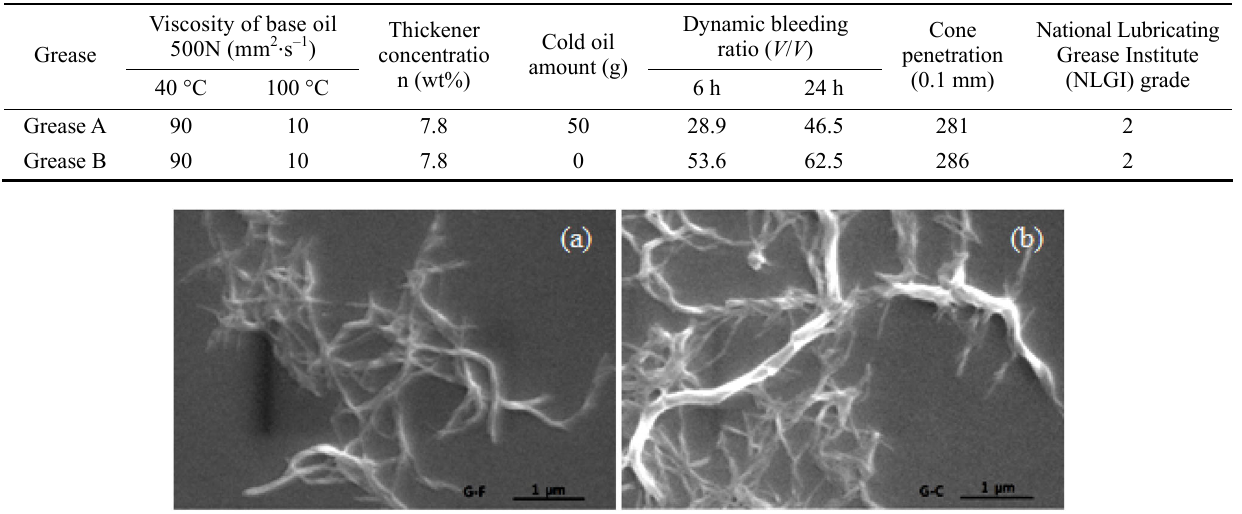
Table 2 Properties of the lubricants used in the experiments.